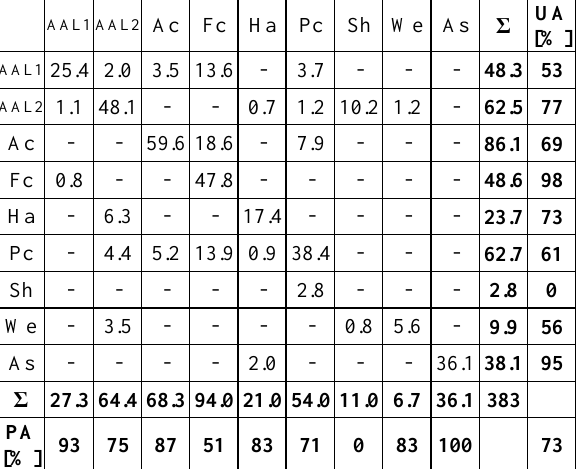
Figure 8. Class homogeneity validation using standard deviation NDVI